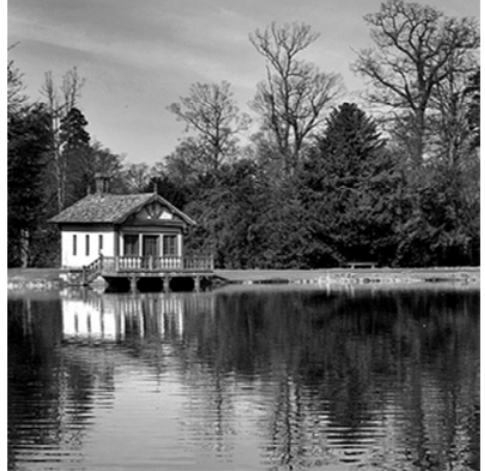
age of lake.tif (400 2